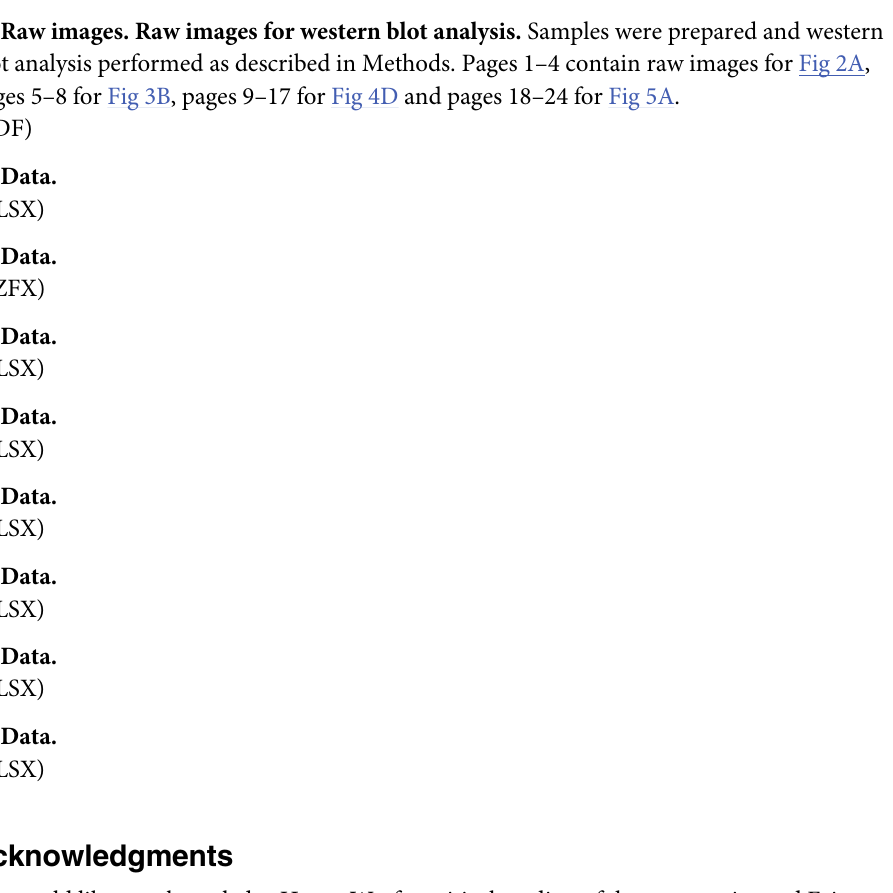
S5 Fig. Zn/Pyr treatment negates effect of Zip7 inhibition. Inhibition of Zip7 with NVS-ZP7-4 resulted in the induction of CHOP, occluding and xBP-1s (lane 3). These proteins were also induced by NVS-ZP7-4 in the presence of IL-1 β /TNF- α (lane 4). However, inclu- sion of the Zn ionophore Zn/Pyr while Zip7 was inhibited by NVS-ZP7-4 prevented upregula- tion of these er stress proteins. S6 Fig. Inhibition of Zip7 results in increased sXBP-1, a sign of ER stress. Cells were treated with NVS-ZP7-4 or NVSZP7-6 alone or with IL-1 β /TNF- α At 6h, IL-1 β /TNF- α alone increased sXBP-1 approximately 2-fold, NVSZP7-4 alone increased levels of sXBP-1 approxi- mately 5-fold and IL-1 β /TNF- α + NVS-ZP7-4 increased levels approximately 10-fold. At 30h, IL-1 β /TNF- α alone increased sXBP-1 approximately 2-fold whereas IL-1 β /TNF- α and NVS-ZP7-4 increased sXBP-1 approximately 4-fold. NVS-ZP7-6 had no effect on